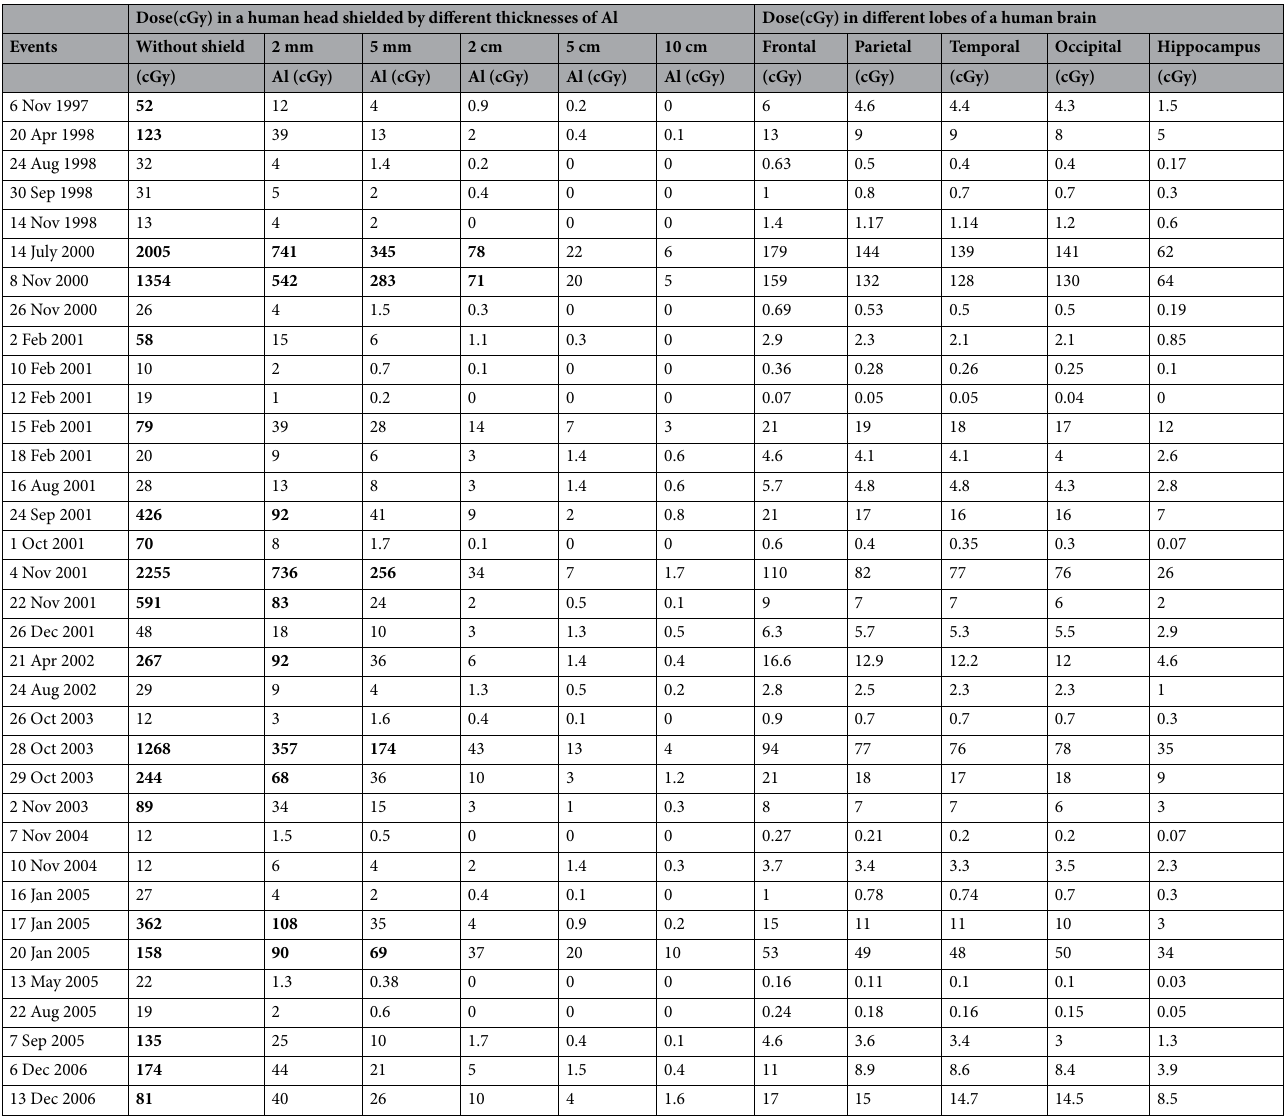
Table 1. Resulting dose (cGy) from 35 SEP events in a human head considering different thicknesses of Al as a shield around an astronaut’s head/body. Dose deposits in different lobes of the human brain protected by 2 mm of shield are also shown. Those event doses that exceed 50 cGy are shown in bold font. These 35 events are chosen from the list as they would deposit more than 10 cGy of dose in the head without shielding (second